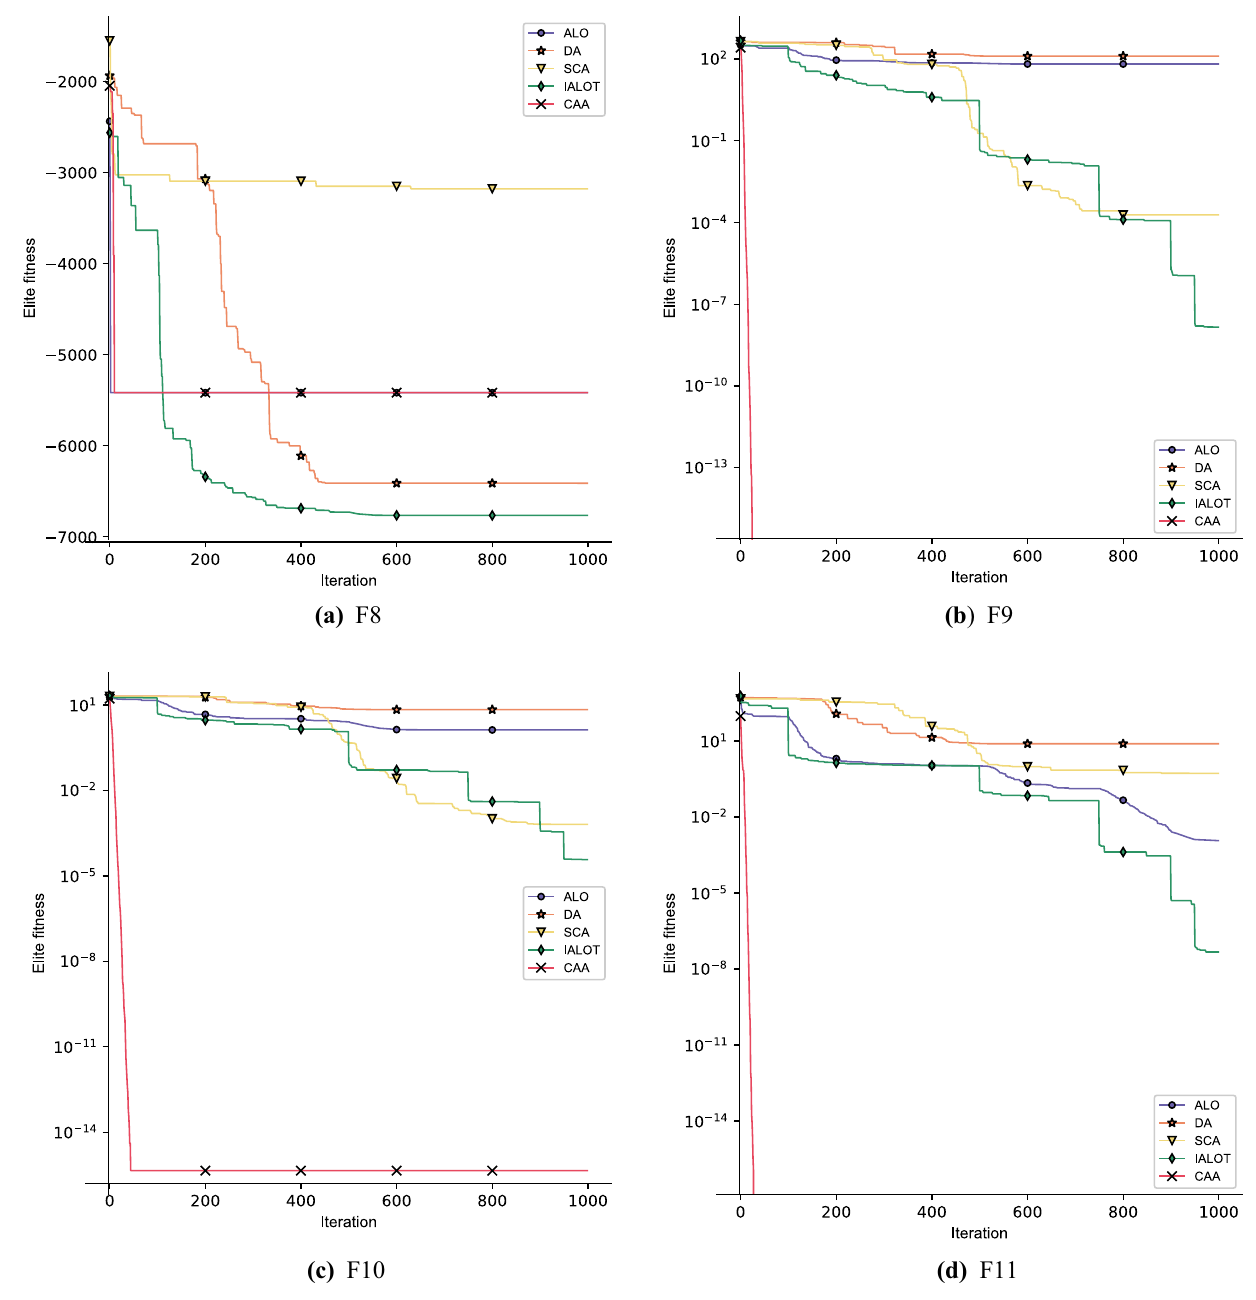
Fig. 9 Convergence curve of five algorithms on multidimensional multimodal